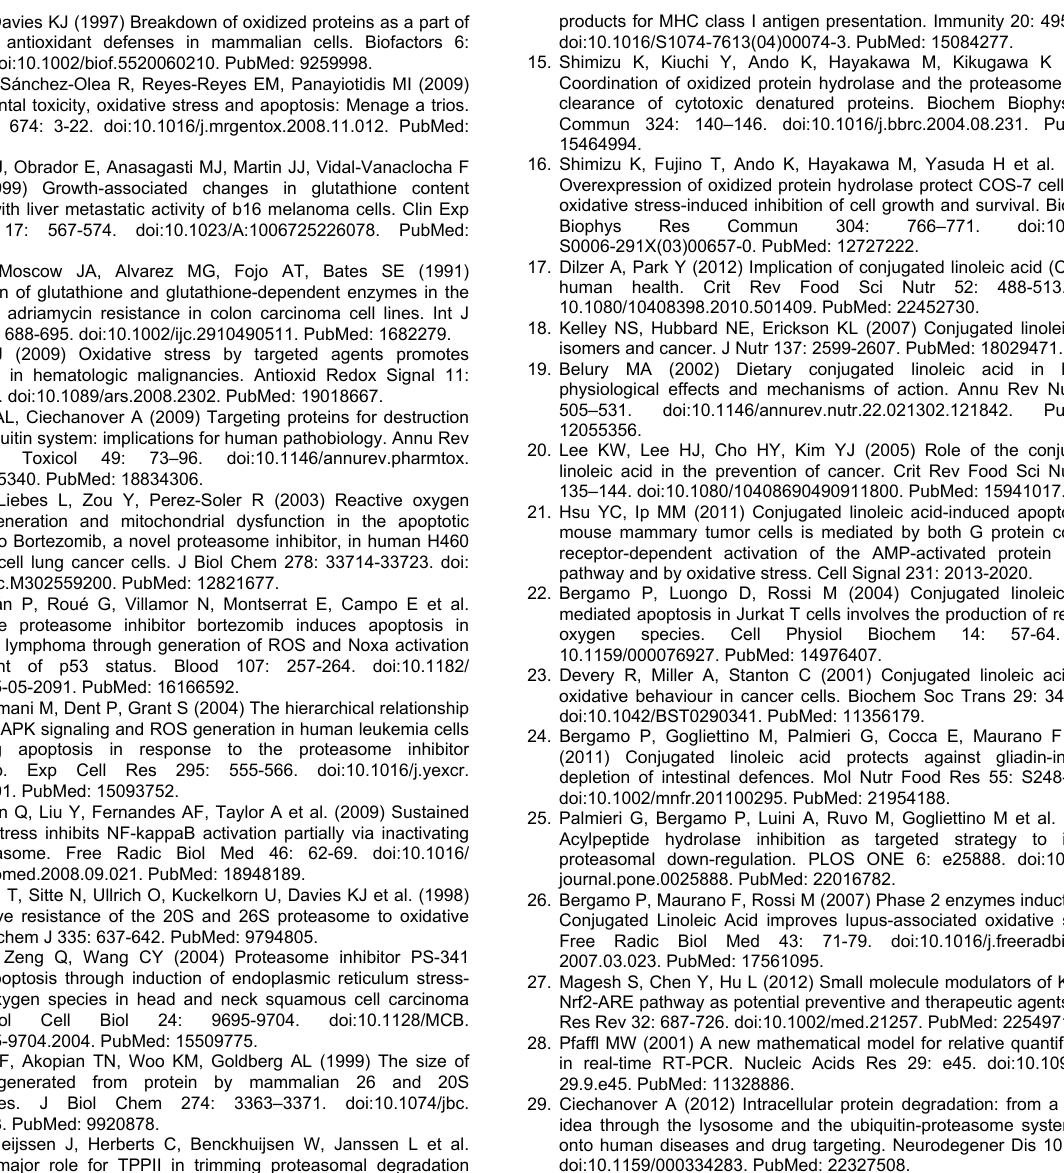
Figure S2. mRNA levels of GCL and NQO1 in A375 cells treated with 50 or 200 μM of t10,c12-CLA for 24h. The mRNA levels were evaluated by RT-PCR and expressed as fold change in comparison to untreated cells. *Significantly different (P < 0.01) from respective